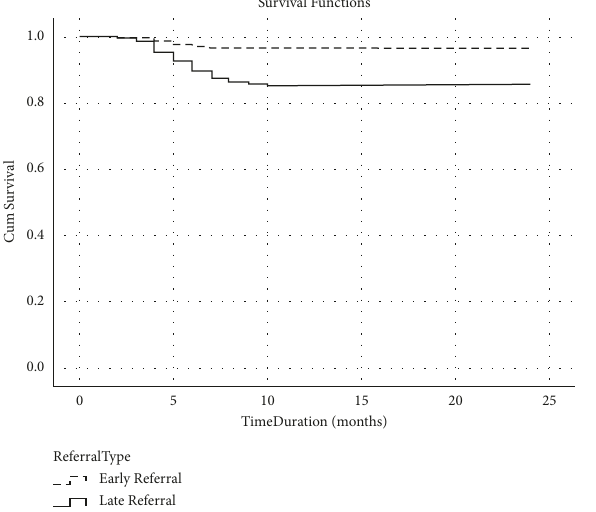
Figure 2: Kaplan-Meier survival curve by the timing of referral pattern in CKD.